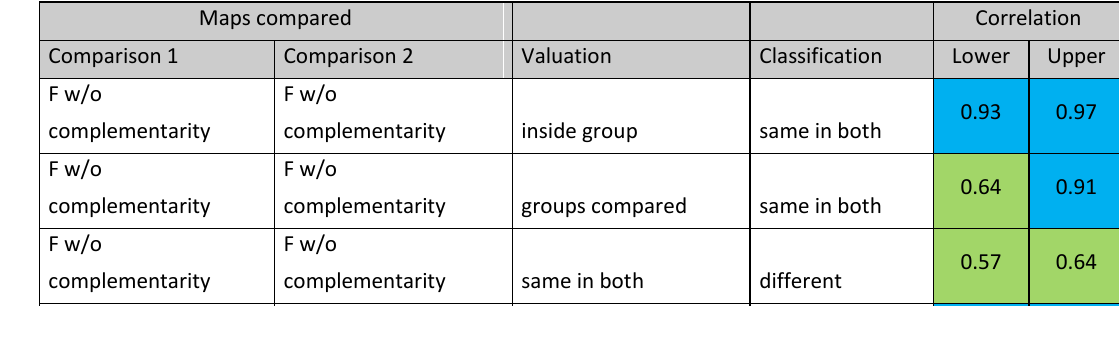
Table 3: Correlations between different conservation value and ecosystem service maps. Abbreviation F refers to FRAGSTATS based maps and Z to Zonation based maps. Valuation refers to habitat type valuation alternatives. ‘Inside group’ means that correlations between conservation value maps in which valuation alternatives were compared inside groups; groups are valuation alternatives 1–3 and 4–6. In the ‘groups compared’ comparisons valuations of group 1–3 were compared to valuations of group 4–6. ’Human or not’ refers to correlations between valuations where human habitats were either given or not given value using same valuation alternative (alternative 1–6). Classification refers to two habitat type classification alternatives (OBIA and